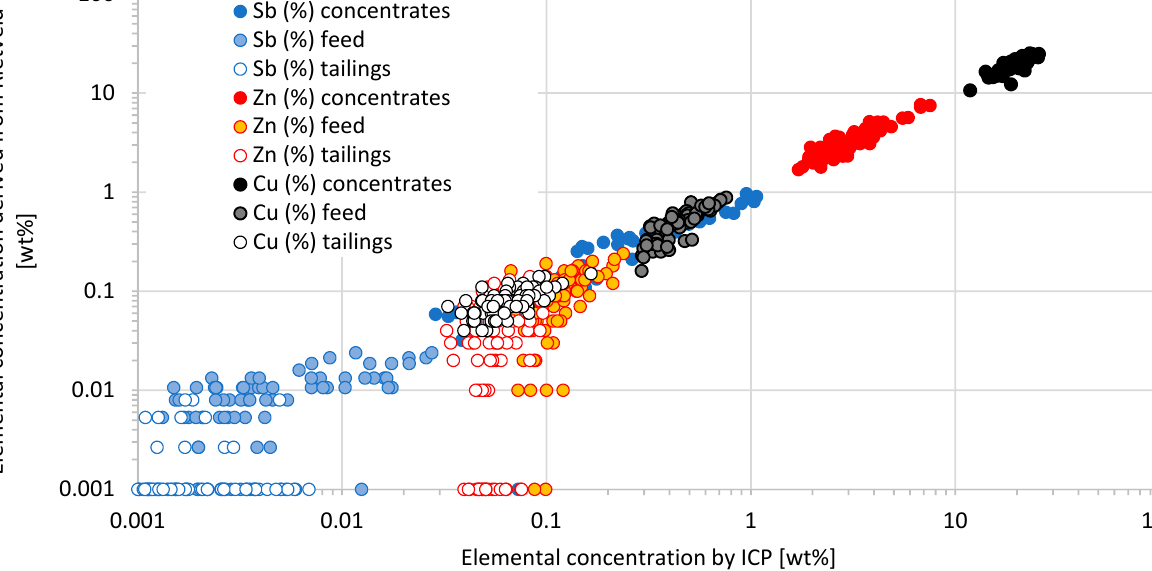
Figure 7. Agreement between chemical compositions obtained from ICP and Rietveld refinement. Zero values obtained by Rietveld are set to 0.001 for graphical purpose.